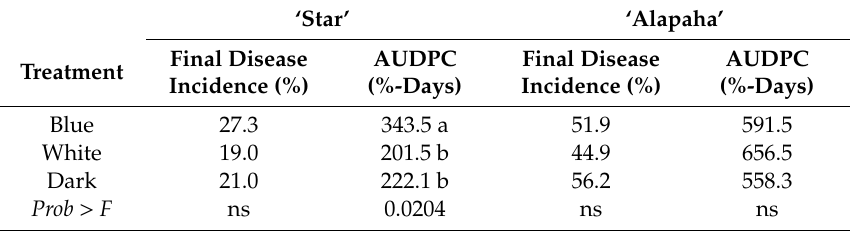
Table 5. Natural postharvest disease incidence (percentage of a ff ected fruit) and cumulative development of disease incidence (expressed as area under the disease progress curve, AUDPC) in ripe ‘Star’ and ‘Alapaha’ blueberries under three light treatments for postharvest storage periods of 21 and 24 days for ‘Star’ and ‘Alapaha’, respectively, followed by another 4 days at room temperature at ambient light.